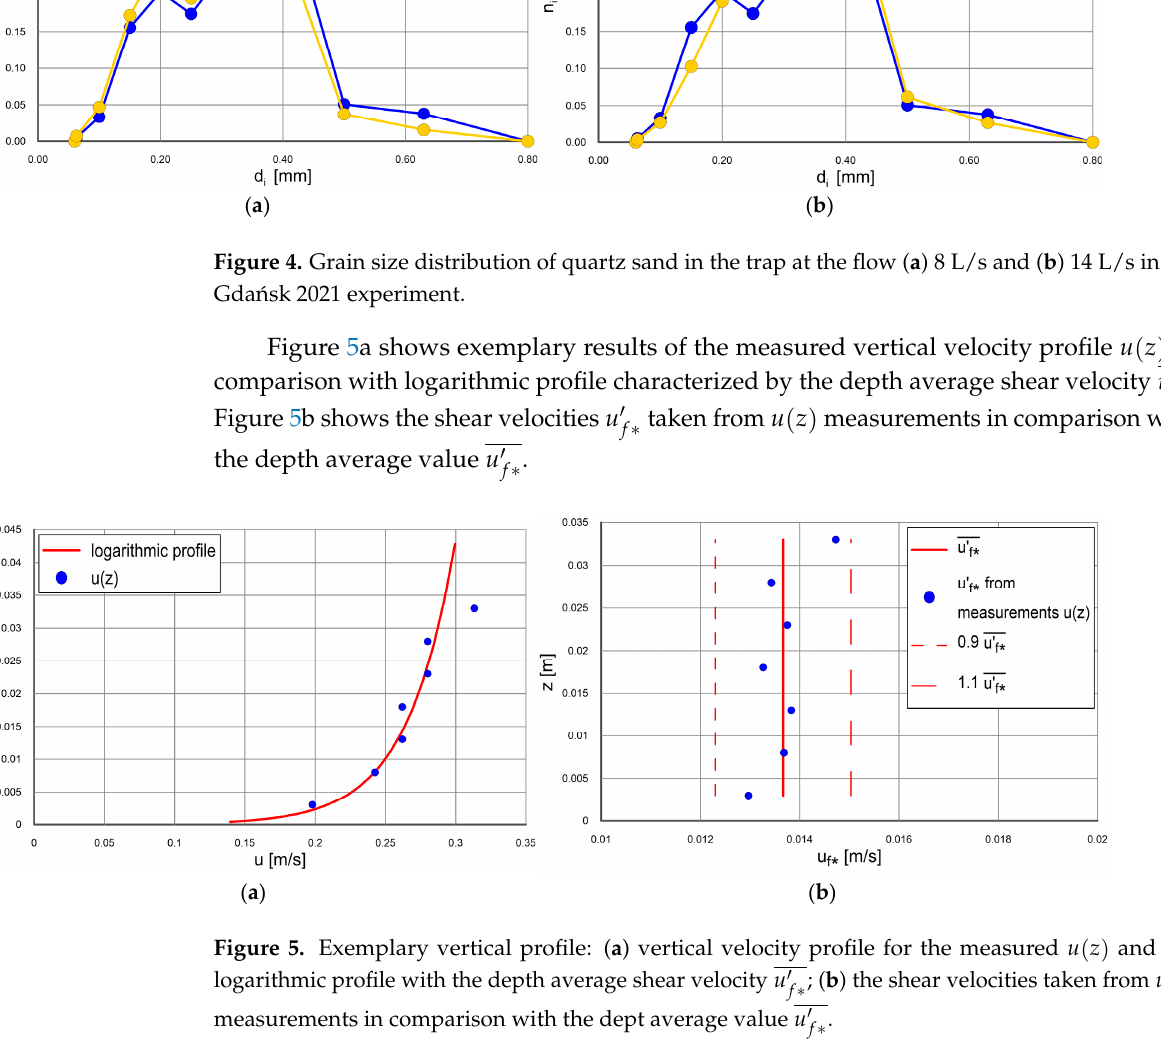
(cid:48) ; ( b ) the shear velocities taken from u ( z ) f ∗ f ∗